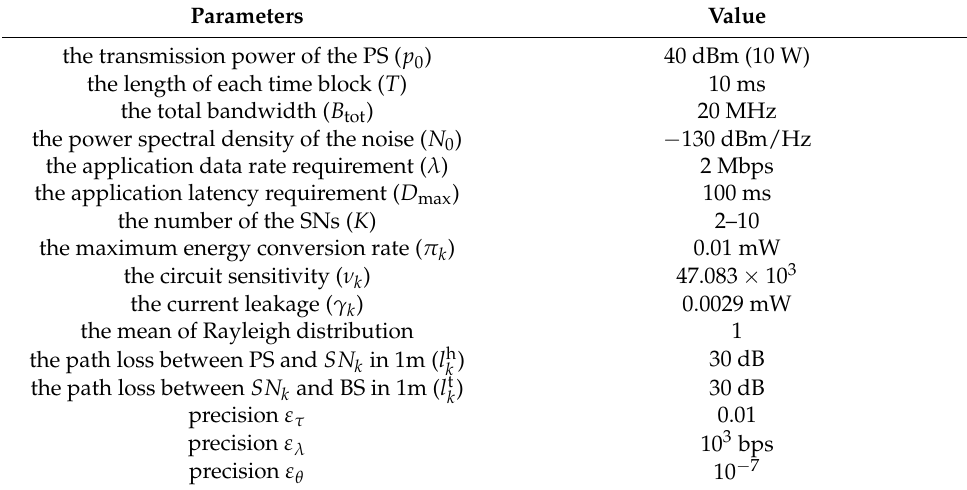
Table 1. Parameter